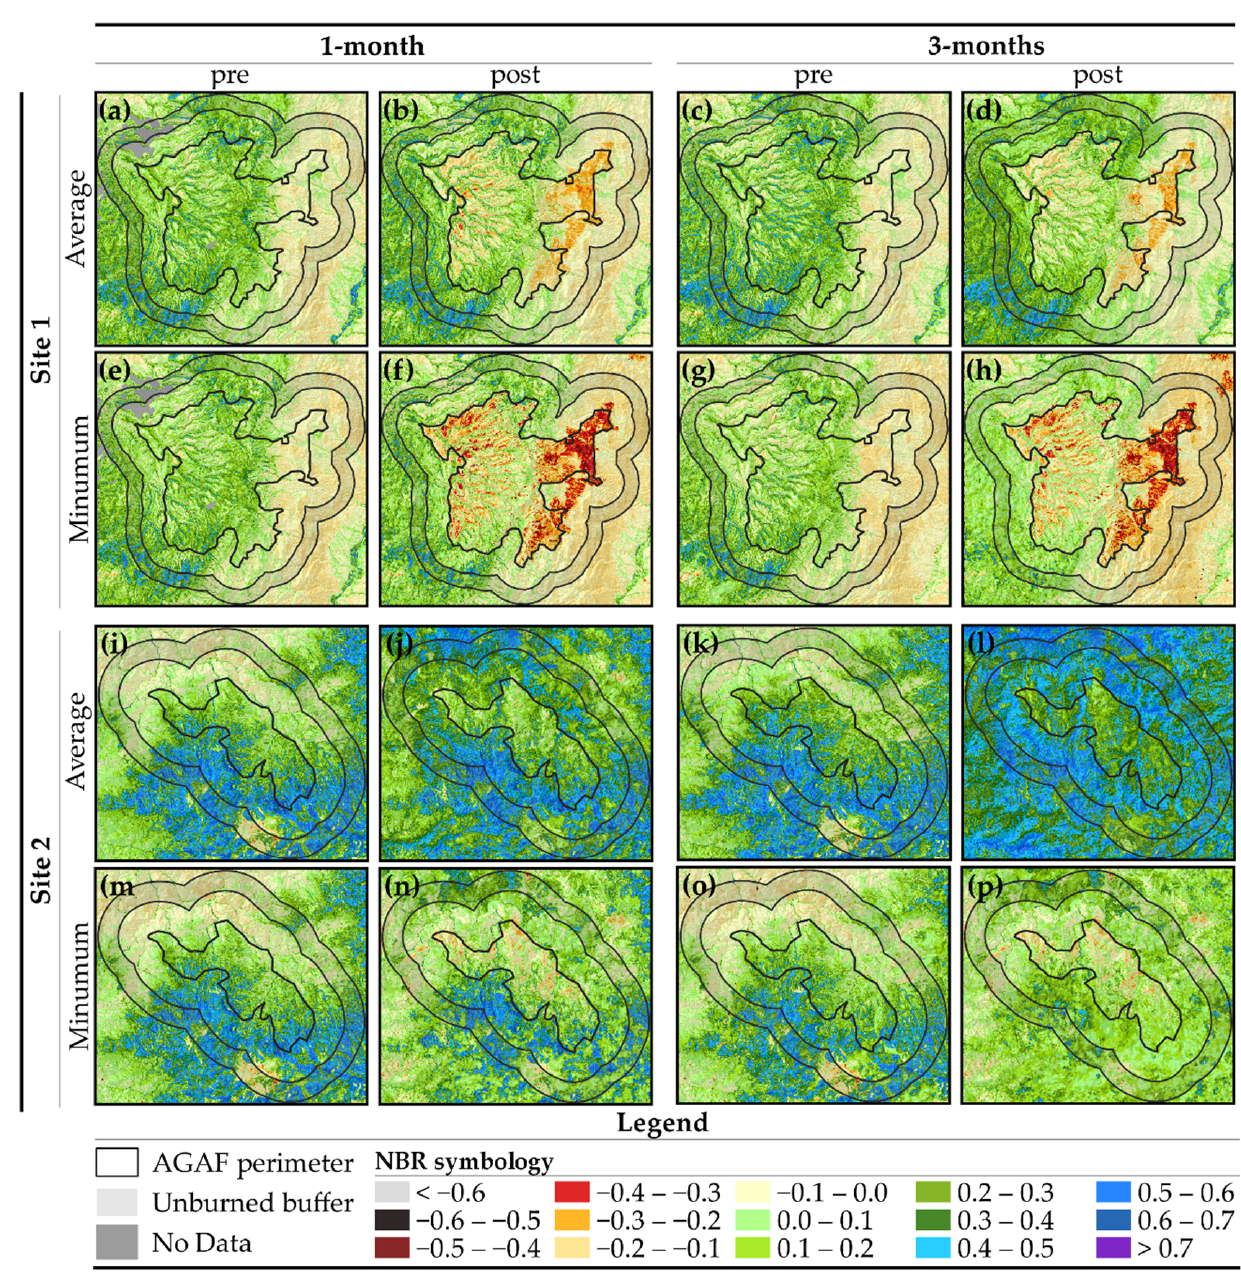
Figure 3. Pre- and post-fire NBR GEE composites with varying techniques average ( a – d ) and ( i – l ) and minimum ( e – h ) and ( m – p ) and different time windows: 1 month (left columns) and 3 months (right columns)) for Sites 1 ( a – h ) and 2 ( i – p ).